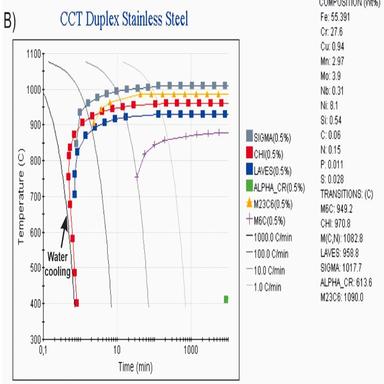
CALPHAD simulation of the soldering process in SDSS-Nb; a) TTT diagram for a temperature of 1090 ◦C; b) CCT diagram for a temperature of 1090 ◦C.